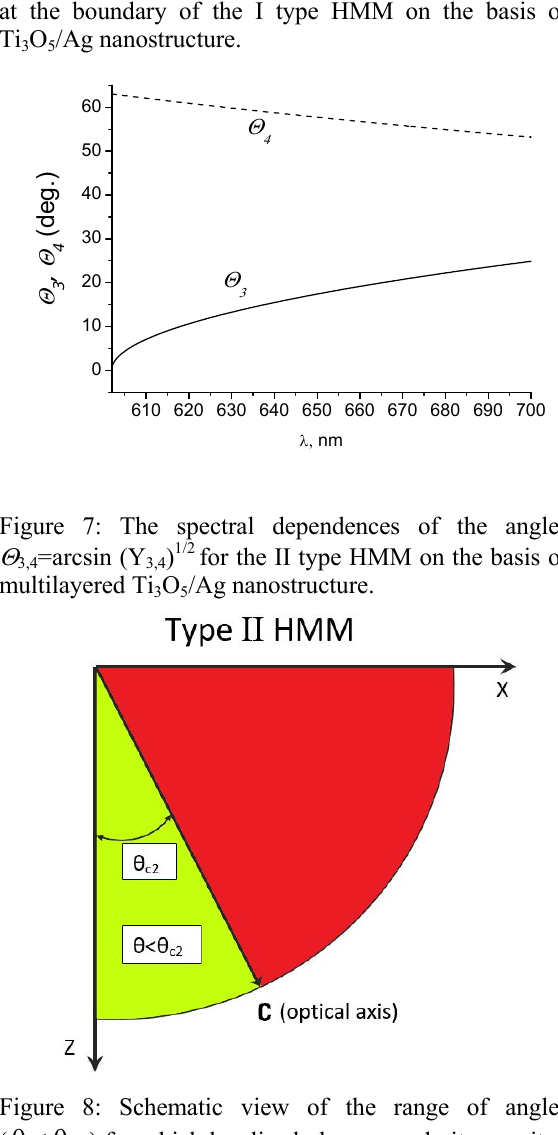
Figure 8: Schematic view of the range of angles θ<θ ) for which localized plasmon-polaritons exit at ( 2 c the boundary of the II type HMM on the basis of multilayered Ti O /Ag 3 5